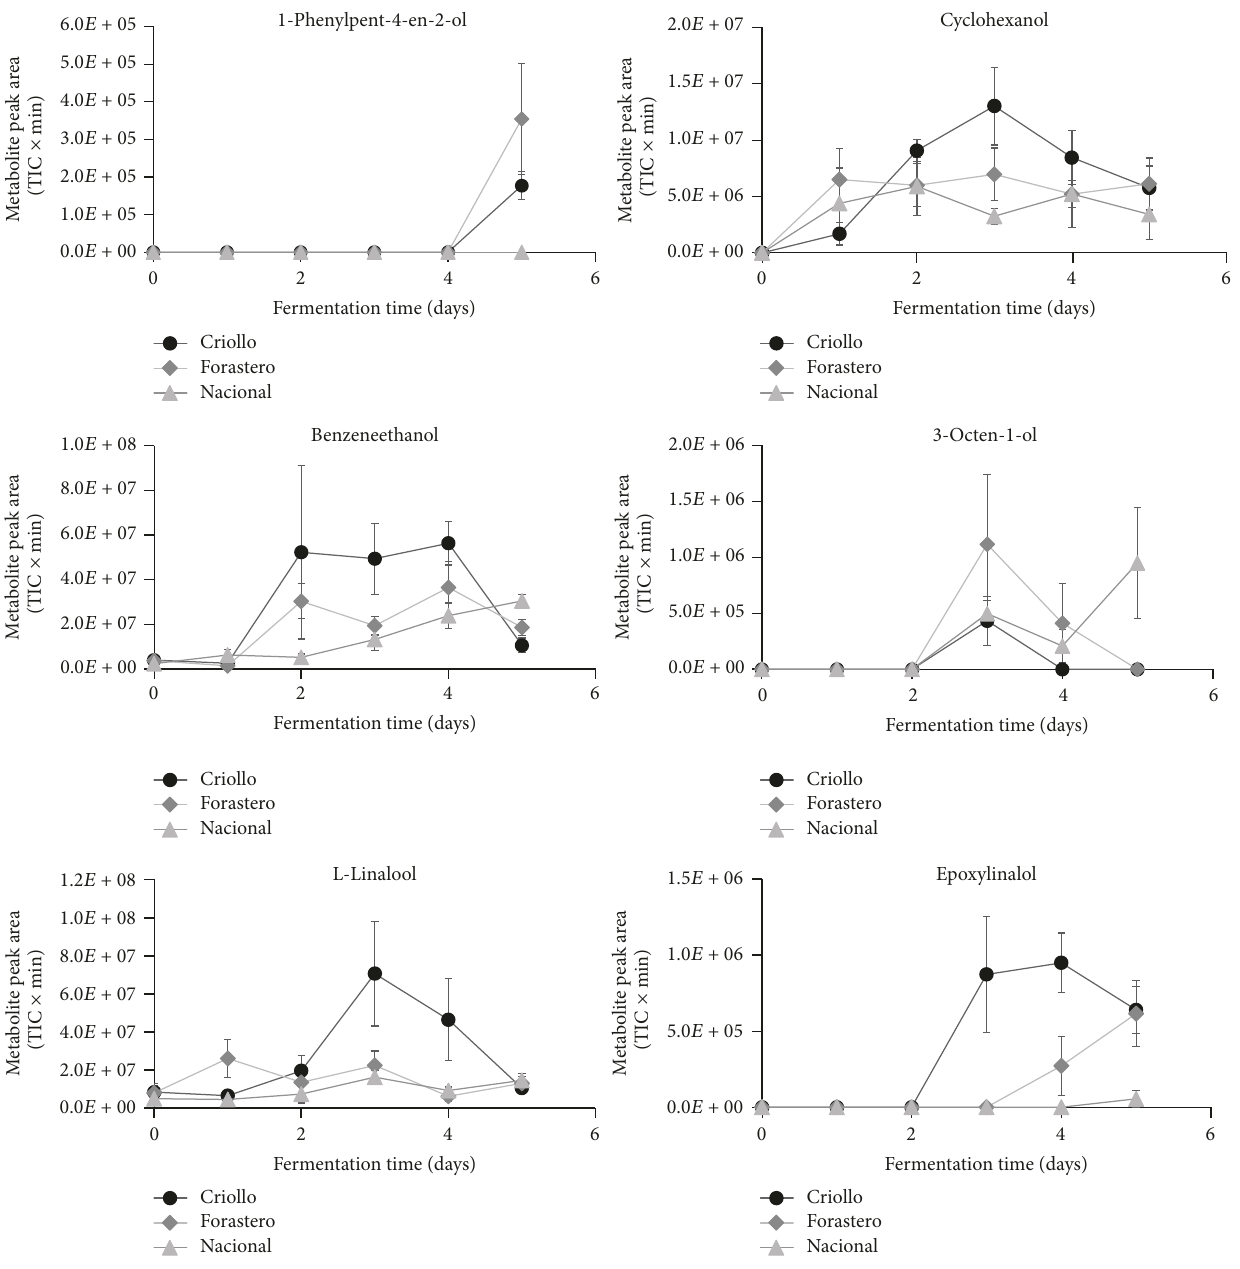
Figure 4: Levels of significant alcohols in Criollo, Nacional, and Forastero beans at different fermentation times. Levels of each metabolite are presented as peak area (total ion current times the differential retention time for each metabolite in minutes). reported no benzaldehyde and low amounts of 2-nonanone genotype as well as growth and fermentation conditions